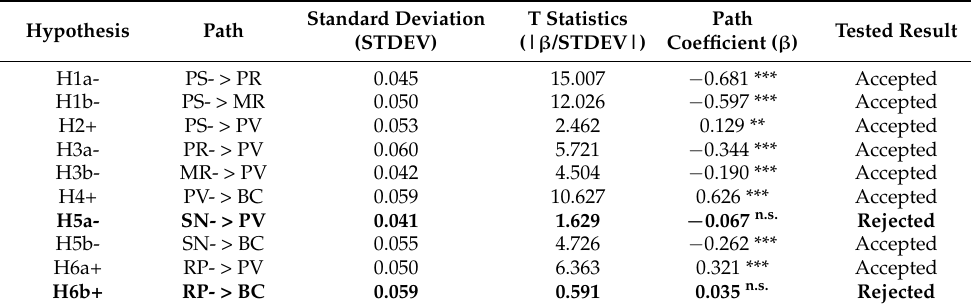
Table 8. Path coefficients estimation of research model to hypothesized test.